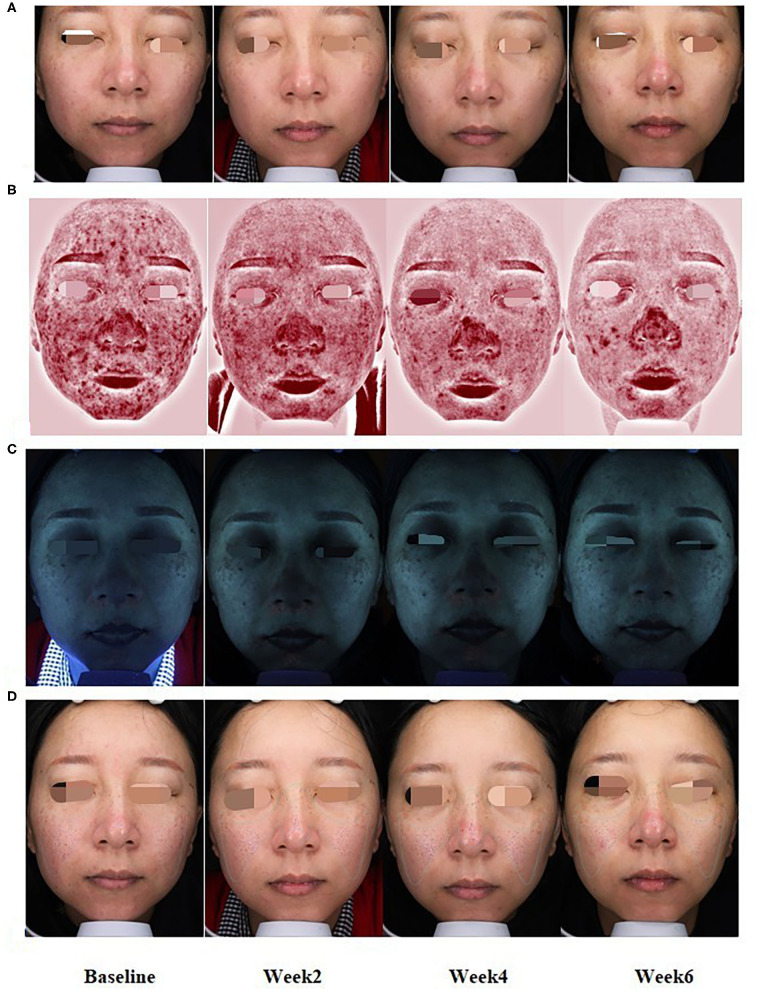
At baseline and weeks 2, 4, and 6 of treatment, representative clinical photographs of FSD patients with normal (A), erythema (B), lipid levels (C), and skin roughness (D) patterns by VISIA.